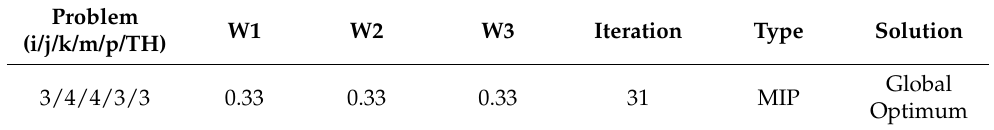
Table 9. Results of solving the case studies with the multi-objective weighting